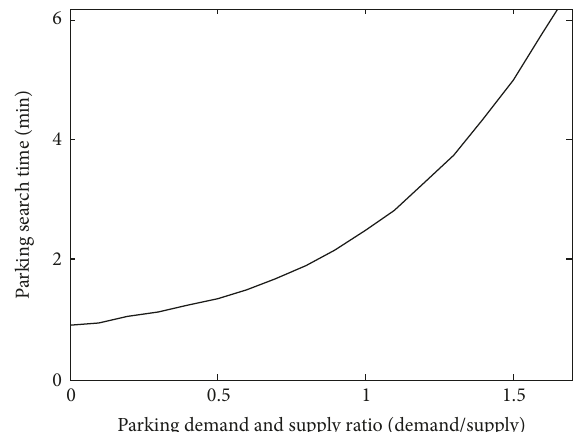
Figure 6: Relation between parking search time and parking de- mand and supply